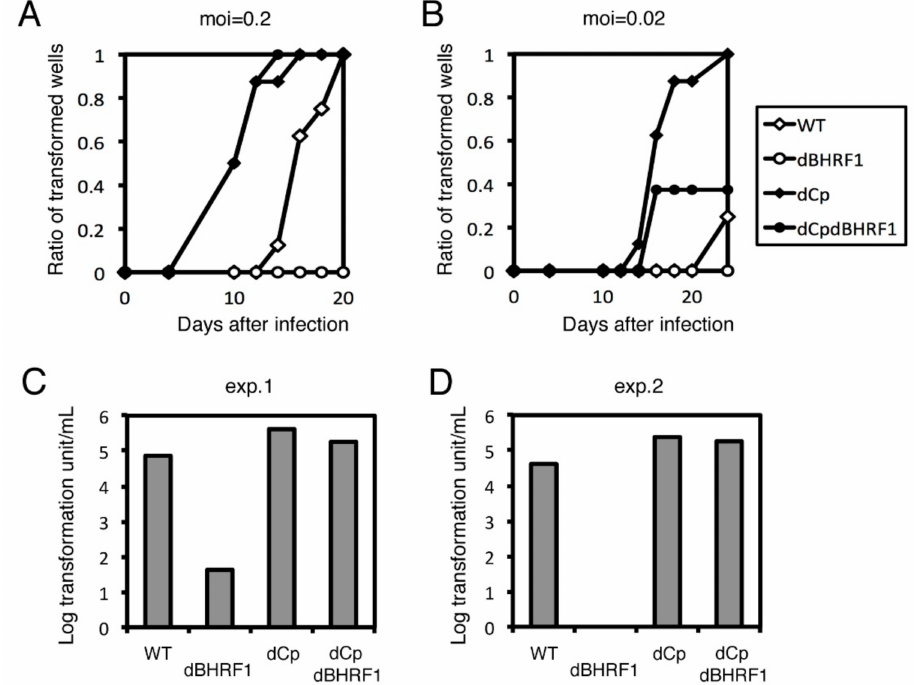
Figure 9. Transformation assay of dBHRF1 and dCpdBHRF1 viruses. Recombinant viruses (WT, dBHRF1, dCp, and dCpdBHRF1) were produced from HEK293 cells. After titer normalization of the viruses, 10-fold serial dilutions were prepared and used to separately infect PBMCs. For each dilution, 8 wells were prepared. ( A , B ) Ratio of transformed wells with a multiplicity of infection (MOI) of 0.2 ( A ) and 0.02 ( B ) over time. ( C , D ) Transformation efficiency at 3 weeks post-infection. Two independent experiments were carried out using PBMCs from two healthy donors (exp. 1 and exp.